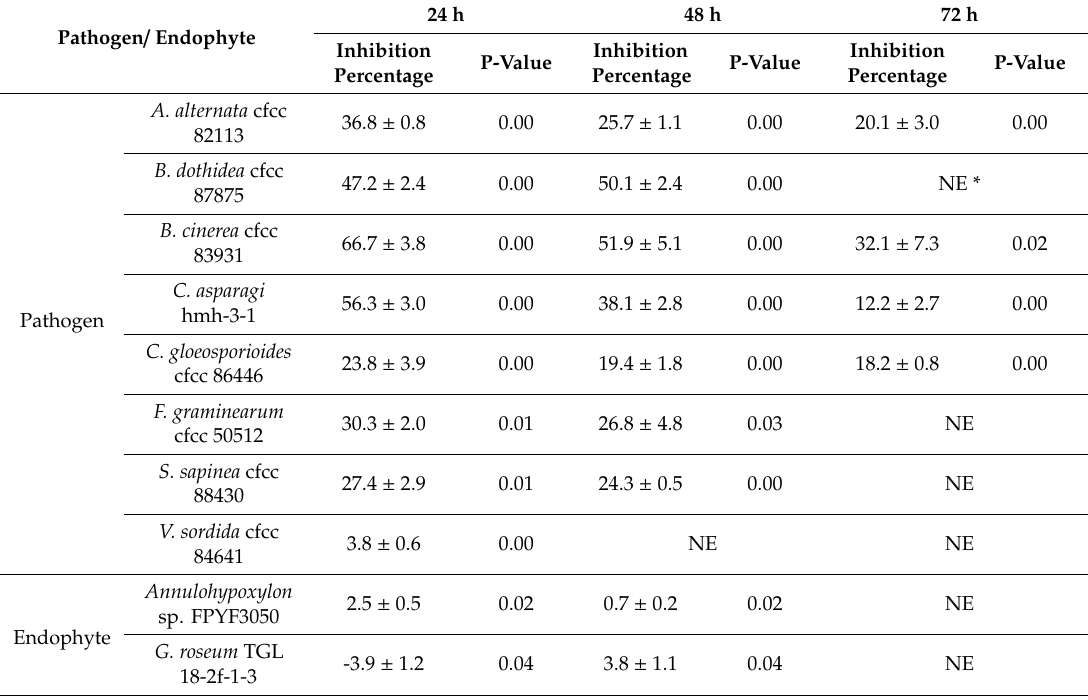
Table 1. Growth inhibition percentages of plant pathogens with volatile organic compounds (VOCs)